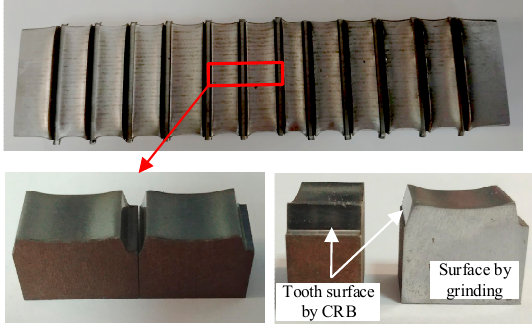
Figure 7. Experimental forming of parts and specimens.